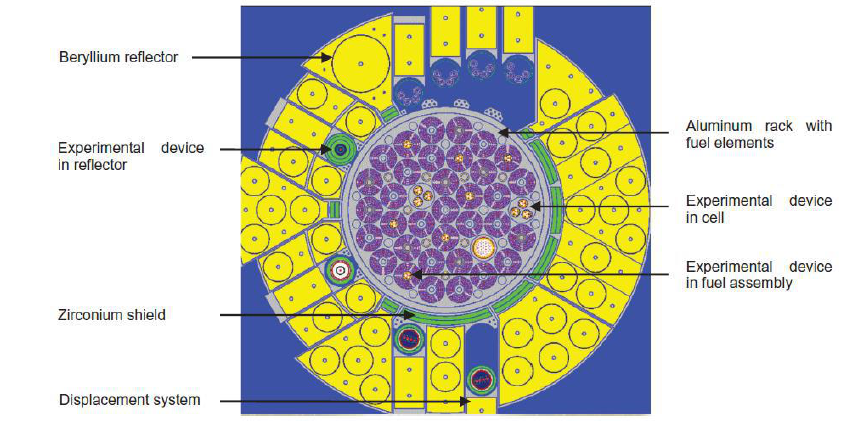
Figure 1. JHR Core